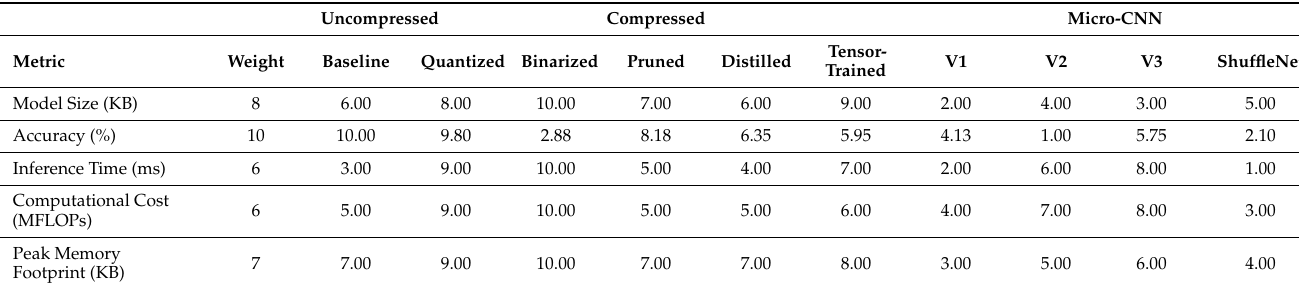
Table 4. Metric scores corresponding to the scaled metric value.